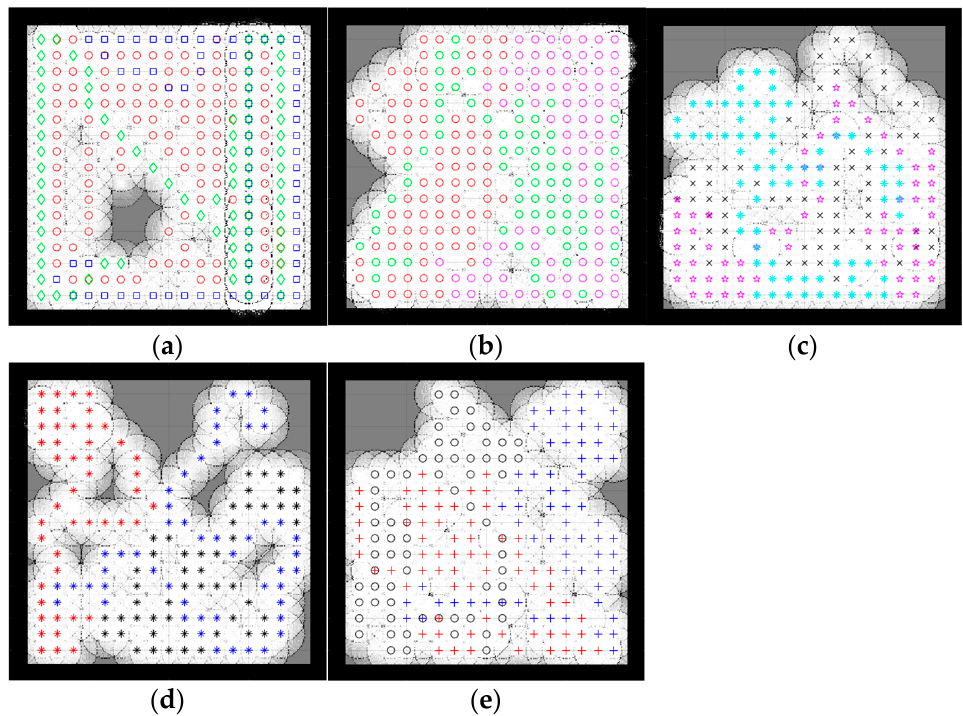
Figure 5. Percentage of the explored area after implementing the CME-SSA and the other approaches on simple map 1. Simple map 1: ( a ) CME 93%, ( b ) CME-SSA 90%, ( c ) CME-GWO 84%, ( d ) CME-SCA 73%, ( e ) CME-GWOSSA 80%.